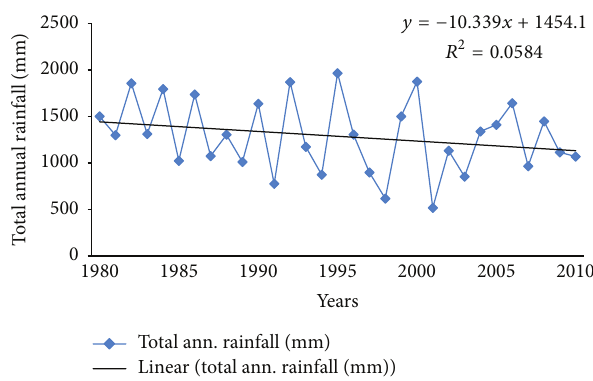
Figure 2: Total annual rainfall (mm) recorded between 1980 and 2010 around the study